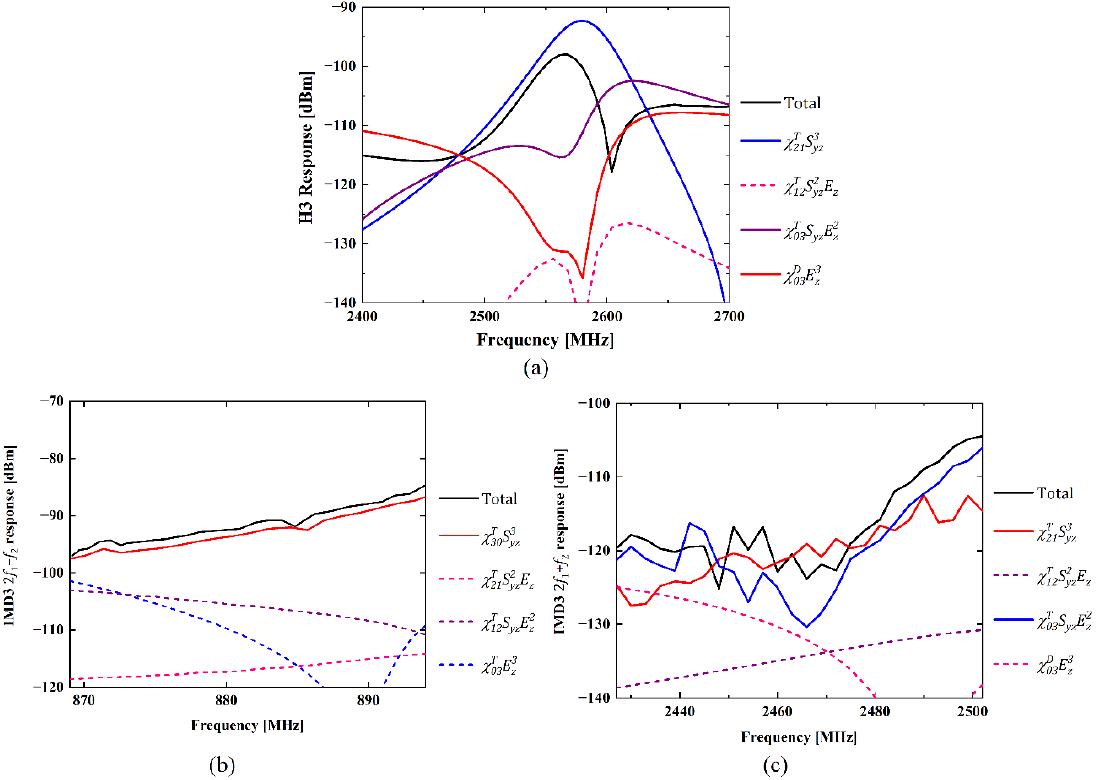
Figure 5. Contributions of employed nonlinear terms to different nonlinear responses: ( a ) H3 response, ( b ) IMD3 2 f 1 − f 2 response, ( c ) IMD3 2 f 1 + f 2 response.